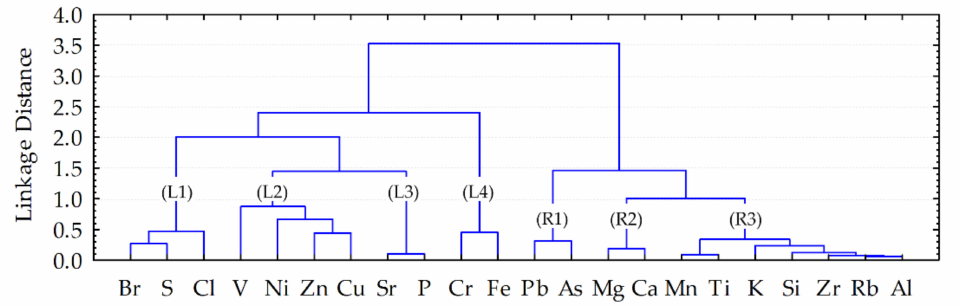
Figure 7. Cluster analysis dendrogram of complete dataset of